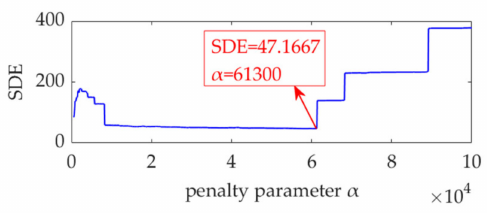
Figure 21. Relationship between penalty parameter α and the SDE index.